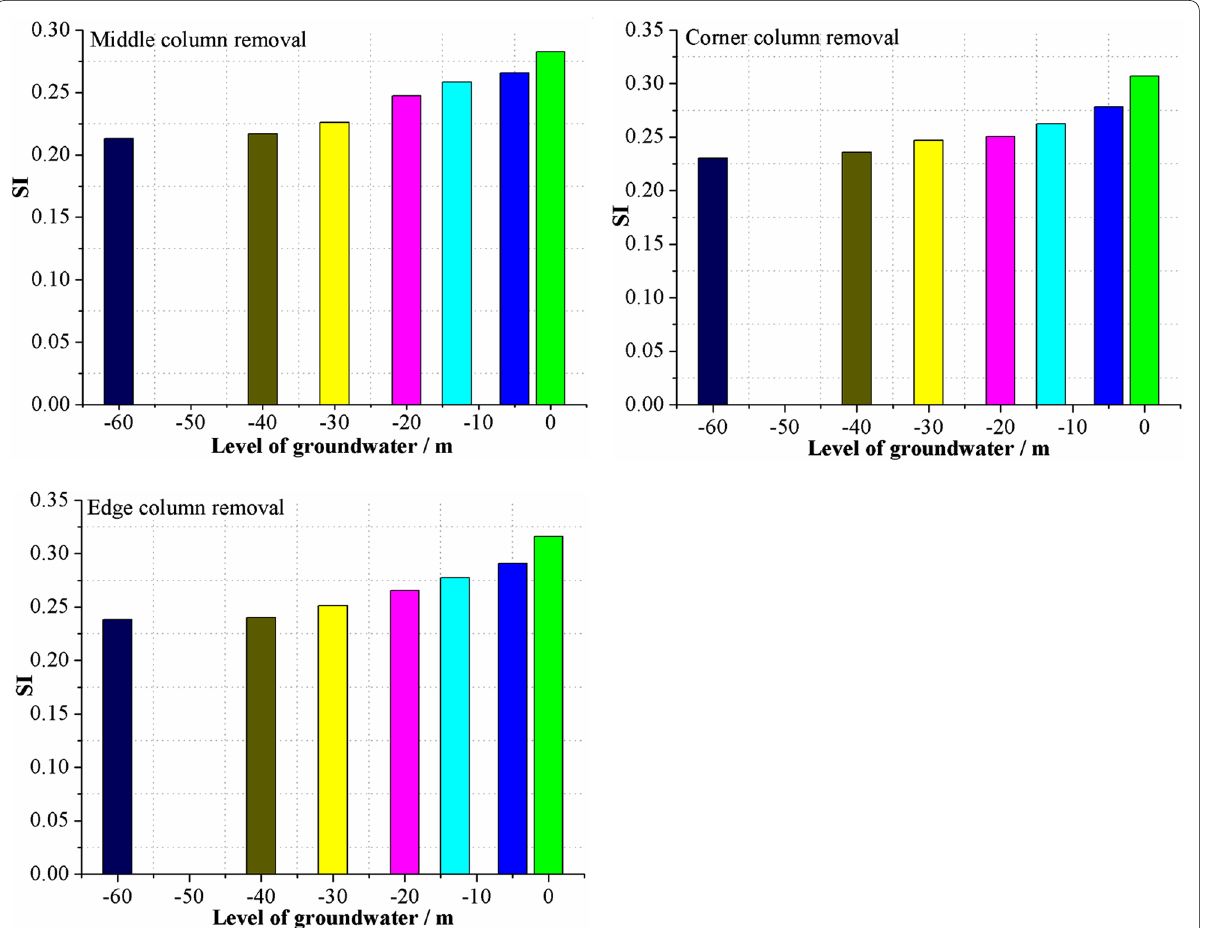
Fig. 19 The plots of the sensitivity index versus the groundwater levels in the substructure